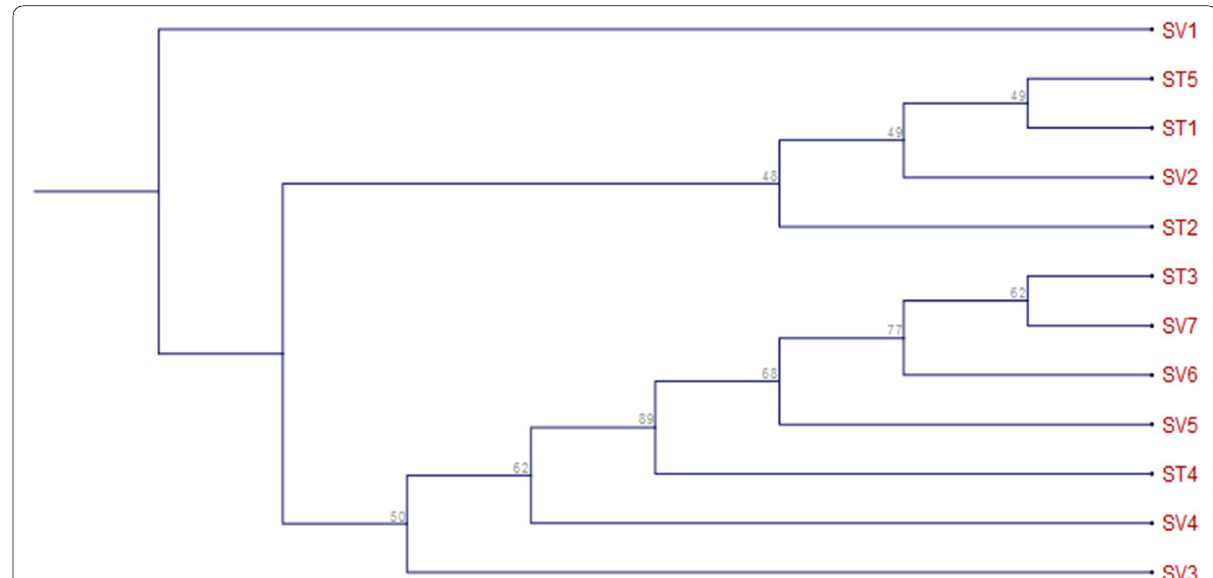
Fig. 6 Using 1000 bootstrap replications, phylogenetic tree of partial rbcL gene sequences